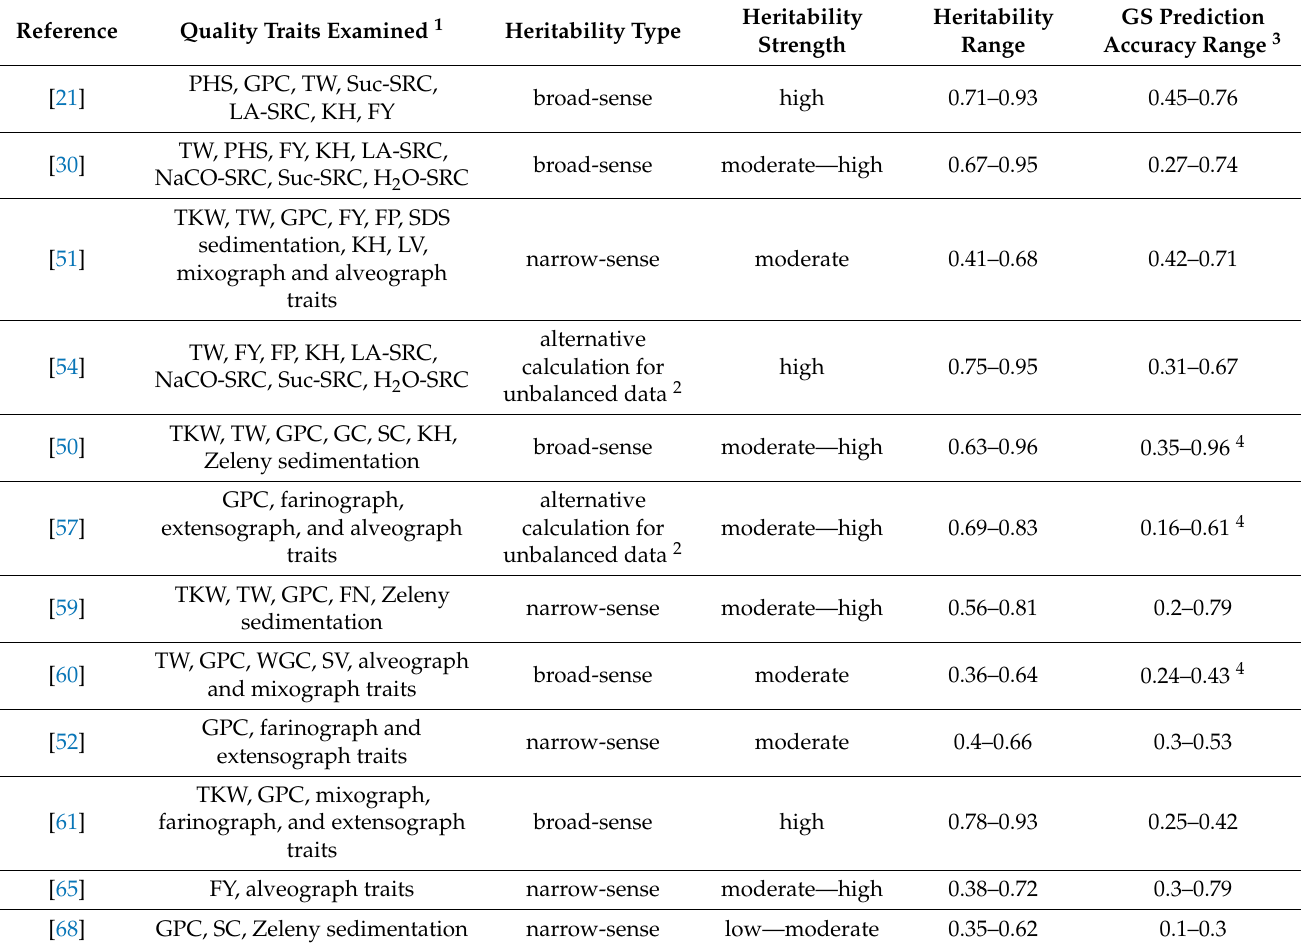
Table 2. Overview of heritability and GS prediction accuracy reported in studies covering wheat quality traits.